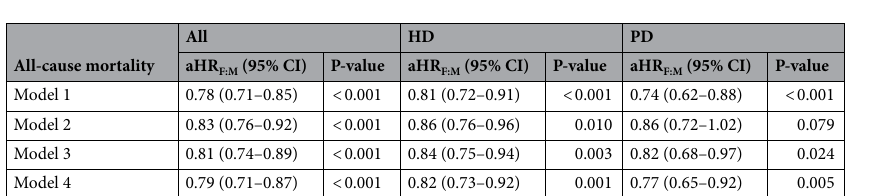
Table 3. Multivariable regression analysis of the association of sex (female versus male) with all-cause mortality. CI confidence interval, F female, aHR adjusted hazard ratio, HD hemodialysis, M male, PD peritoneal dialysis. Model 1: Adjusted for age at the time of dialysis. Model 2: Model 1 + adjusted for body mass index, diabetes, cardiovascular comorbidities (coronary artery disease, cerebrovascular disease, congestive heart failure, arrhythmia, peripheral vascular disease, hypertension), chronic lung disease, moderate to severe chronic liver disease, and malignancy. Model 3: Model 2 + adjusted for albumin, hemoglobin, calcium, and phosphorus. Model 4: Model 3 + adjusted for subjective global assessment scores and dialysis vintage.